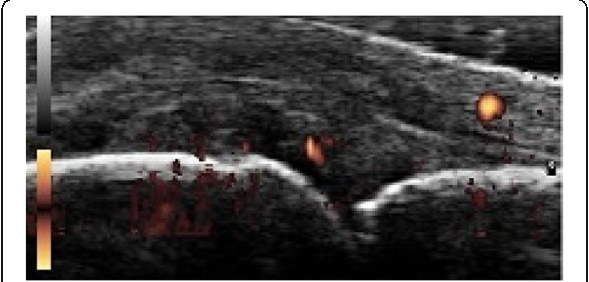
Fig. 2 (abstract P364). Signs of active synovitis (positive PD) in third left metacarpophalange